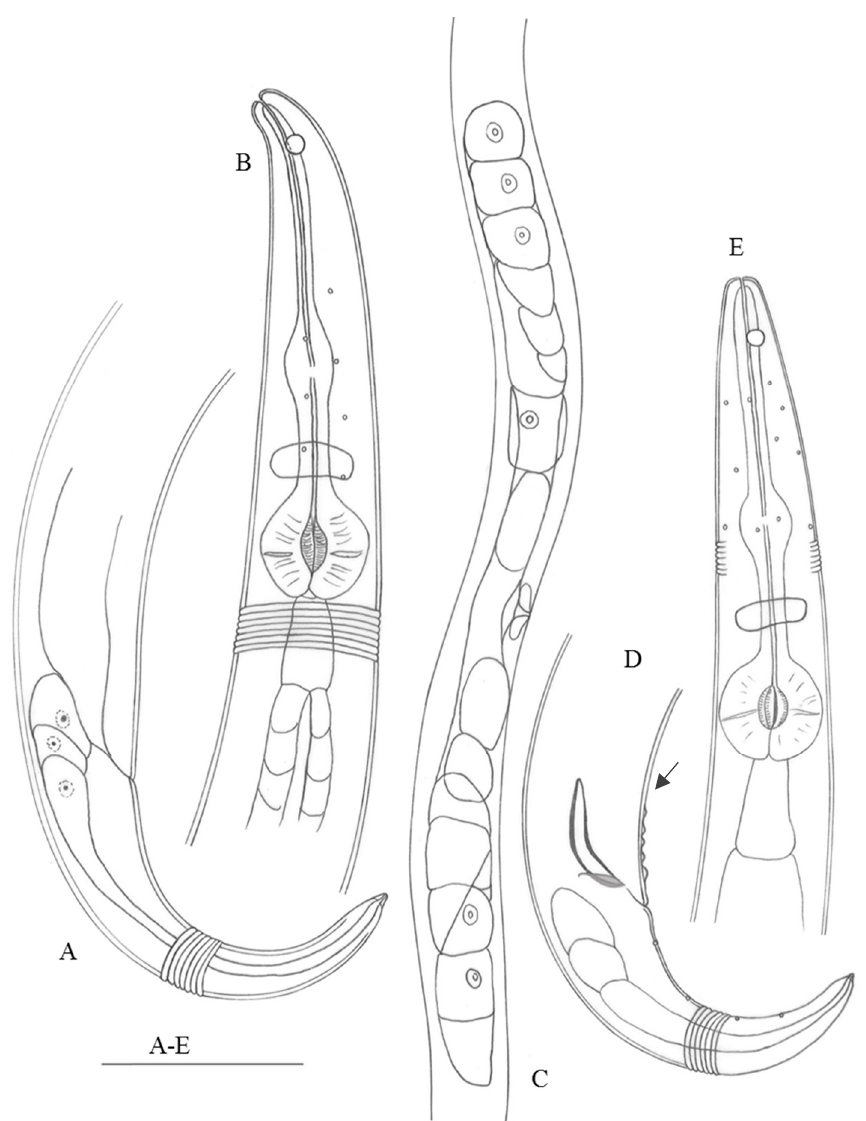
Figure 1. Haliplectus major sp. nov. ( A ) lateral view of female tail region; ( B ) lateral view of female head end; ( C ) lateral view of female body part showing ovaries; ( D ) lateral view of male tail region (arrow indicating supplements); ( E ) lateral view of male head end. Scale bars: ( A , B , D , E ) = 50 µm; ( C ) = 125 µm.